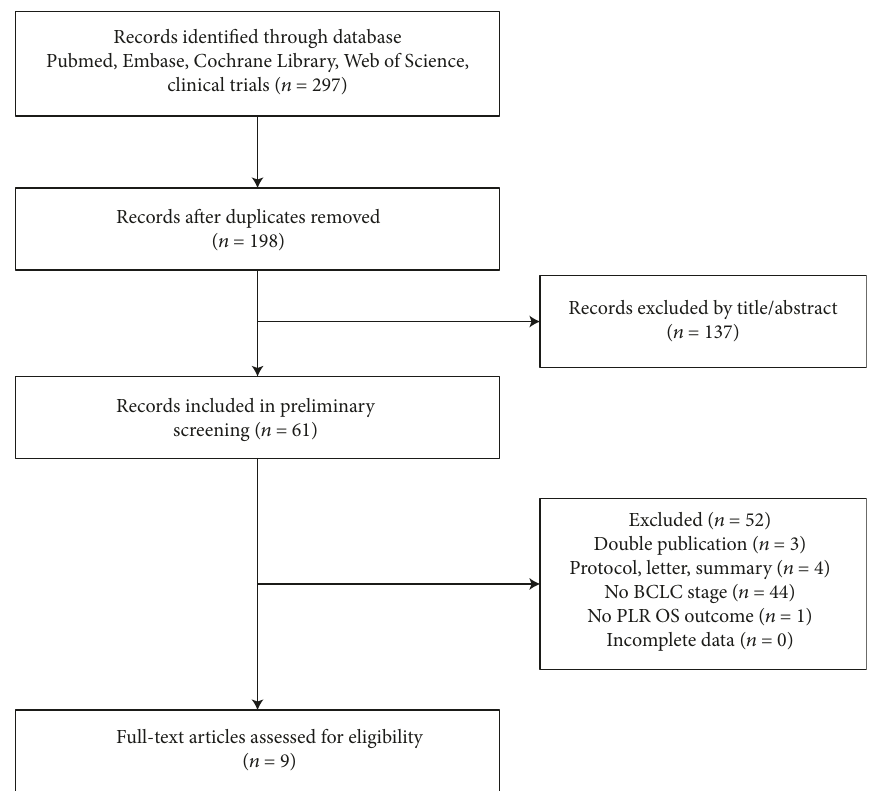
Figure 1: Flow diagram for study identi fi cation and